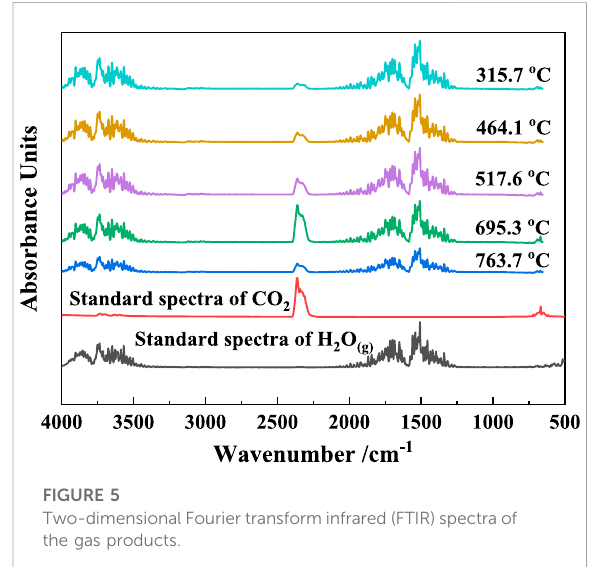
FIGURE 5 Two-dimensional Fourier transform infrared (FTIR) spectra of the gas products.